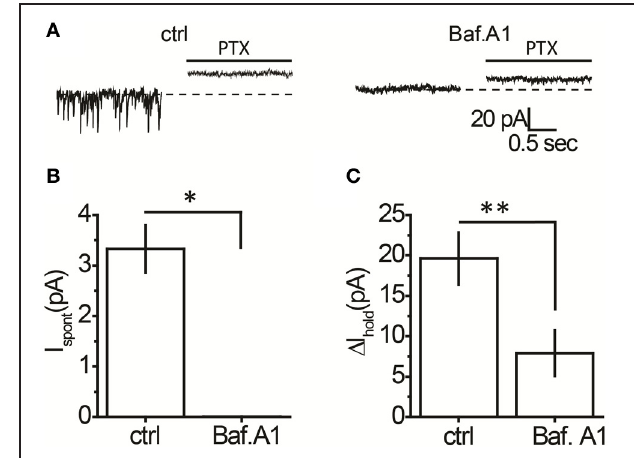
FIGURE 1 | NO711 and SNAP5114 have a synergistic effect on the tonic GABA A current. (A) Changes in I hold produced by SNAP5114 following NO711 application ( upper traces ) and by NO711 following SNAP5114 application ( lower traces ). Dashed lines —baseline or drug-blocked levels of I hold ; black line —application of NO711, gray line —application of SNAP5114. (B) Summary graph of changes in I hold produced by separate applications and co-application of SNAP5114 and NO711, showing a strong interaction between the two transporter antagonists ( n = 6; F ( 1 , 5 ) = 18 . 72, P < 0 . 01,